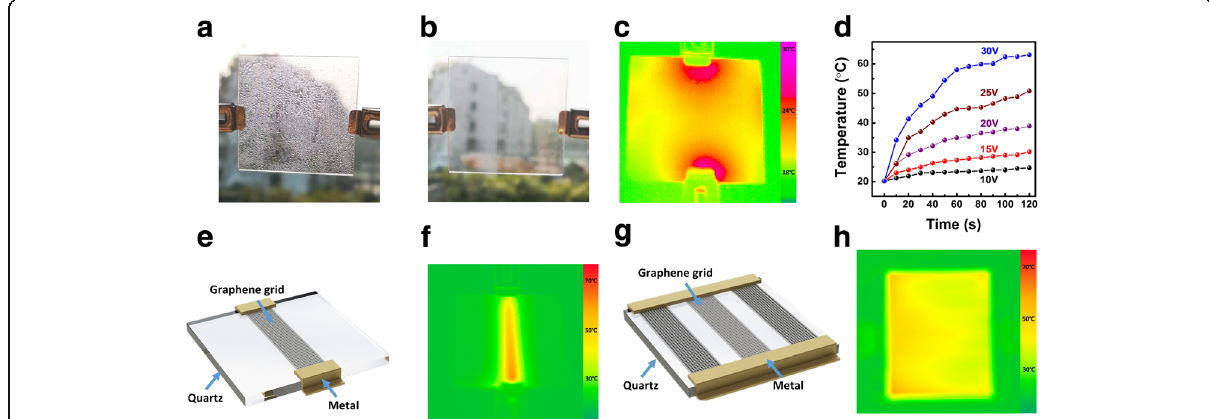
Fig. 4 Defogger based on MGFG. a , b Defogging performance of MGFG. c Contour temperature map regarding the surface of 5 cm × 5 cm MGFG under 20 V. d Temperature profiles of 1 cm × 1 cm MGFG at different voltage and time. e Schematic illustration of MGFG belt defogger. f Contour temperature map of MGFG belt defogger under 25 V. g Schematic illustration of patterned MGFG belt arrays defogger. h Contour temperature map of MGFG belt arrays defogger under 25